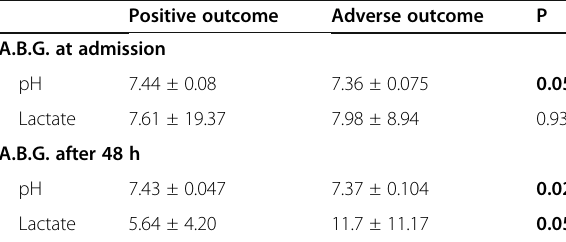
Table 4 pH and lactate at admission and after 48 h Positive outcome Adverse outcome P